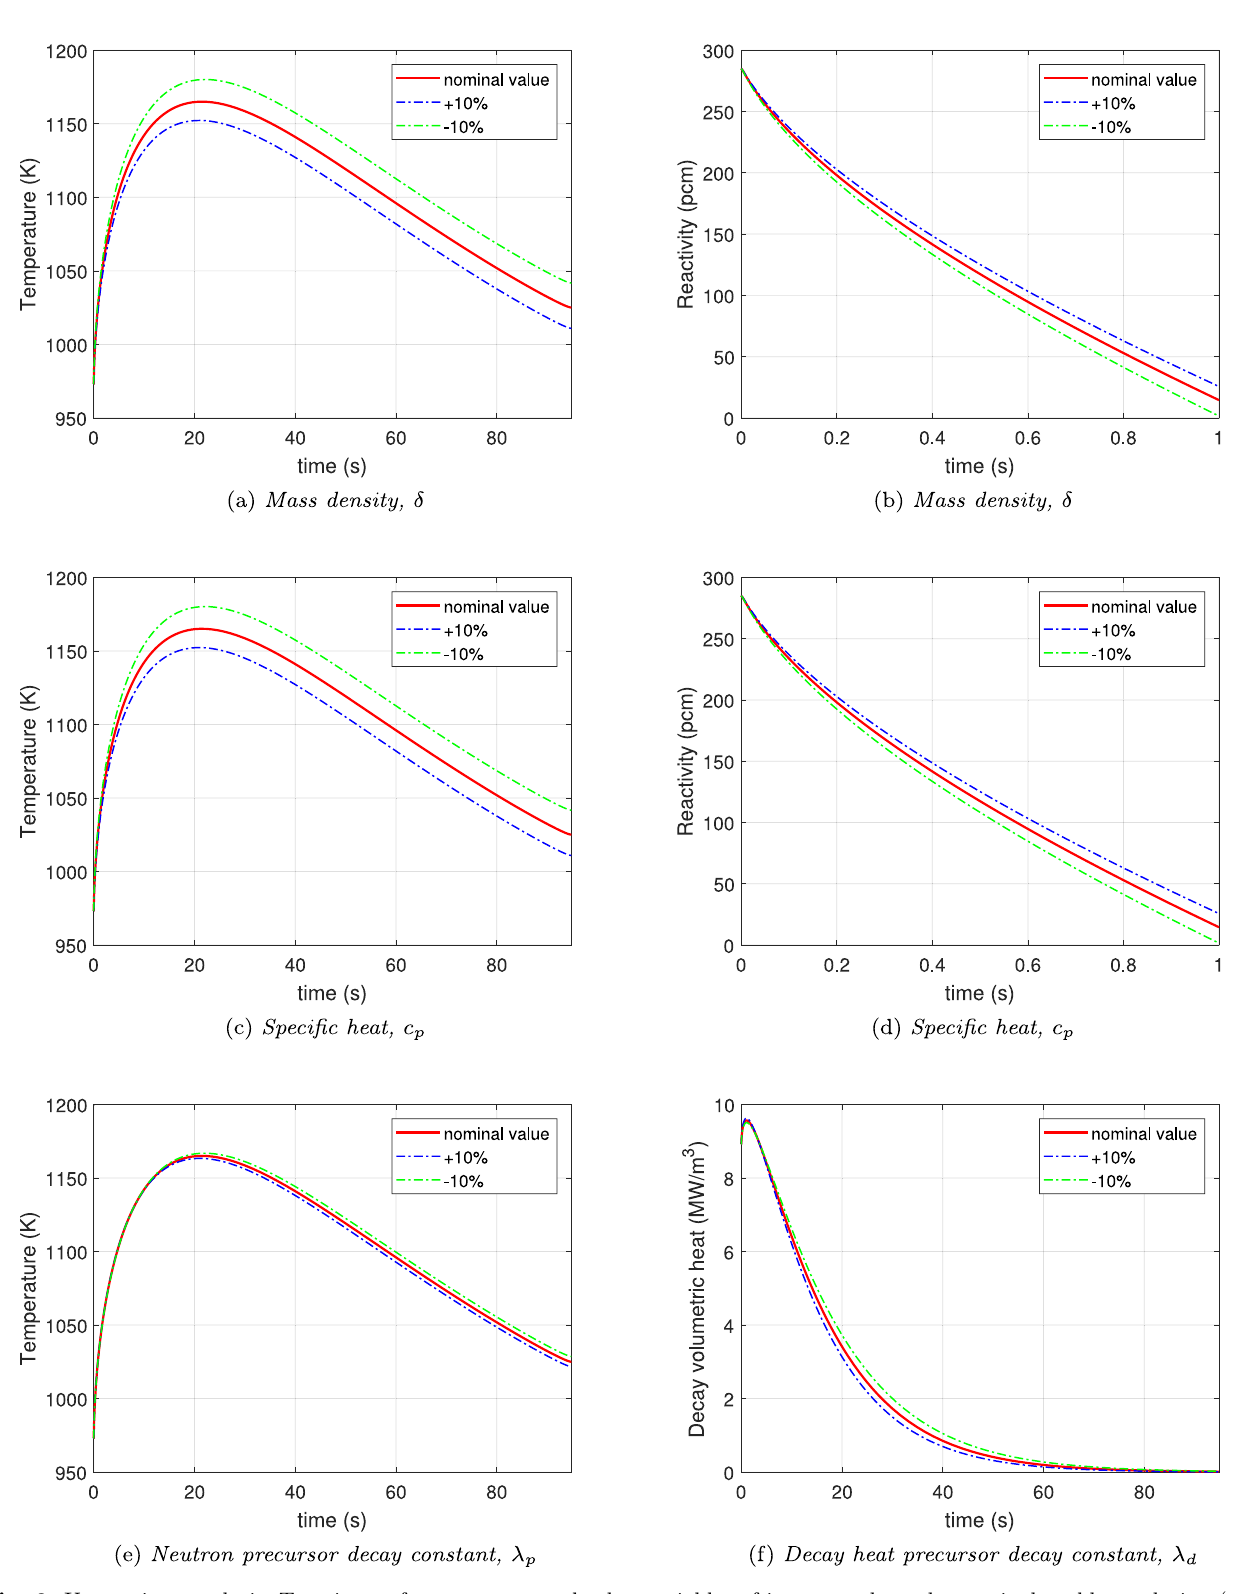
Fig. 8. Uncertainty analysis. Transients of temperature and other variables of interest, where the nominal problem solution (red line) is compared with variation of parameters of ± 10% (dash-dot